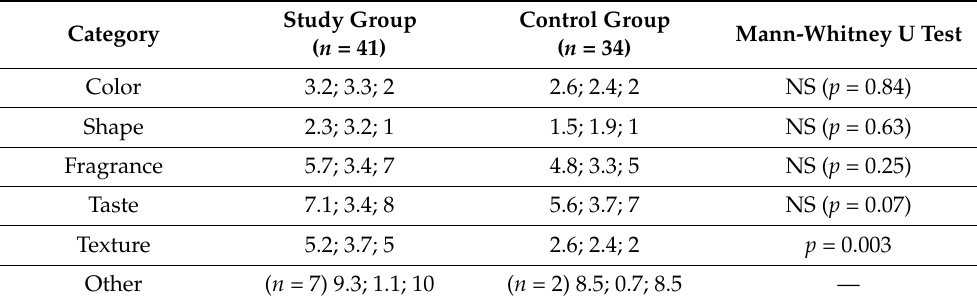
Table 13. Grading scale in selecting meals/products (provided in: mean; standard deviation; median) (question